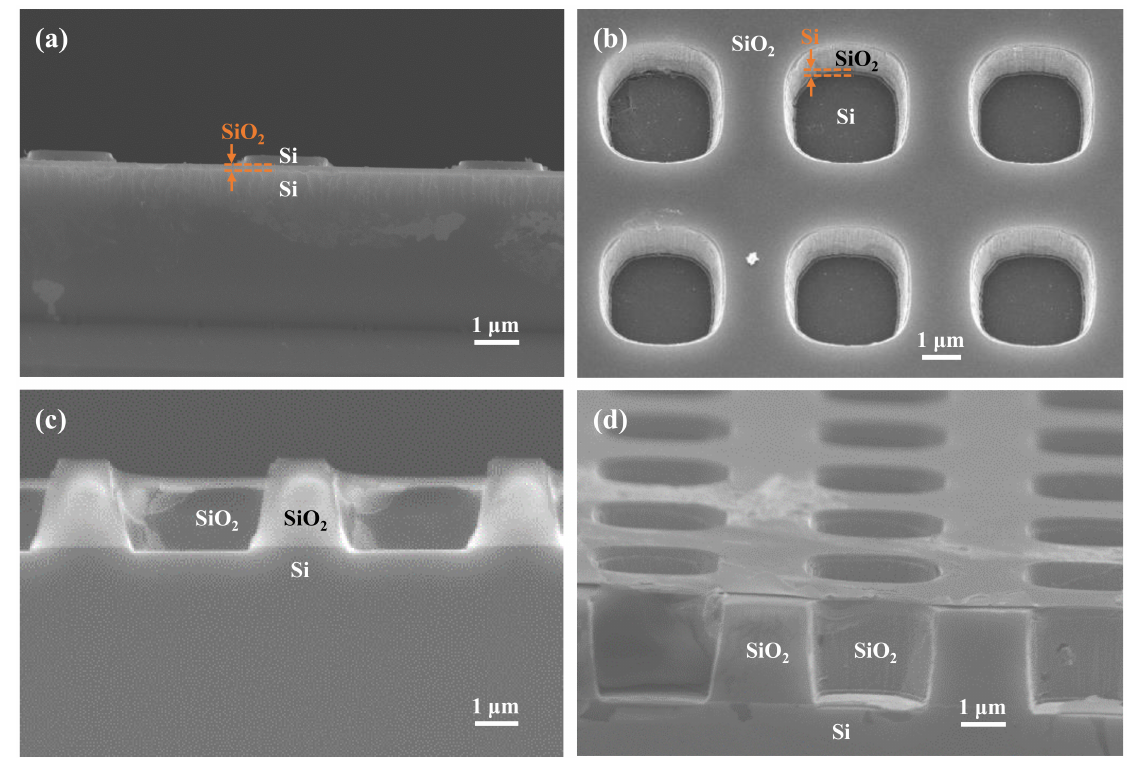
Figure 3. ( a ) Cross-sectional scanning electron microscope image of the releaser piece, ( b ) bird’s-eye-view and ( c ) cross- sectional scanning electron microscope images of the receiver piece with an SiO 2 terrace before the submergence process, and ( d ) bird’s-eye-view scanning electron microscope image of the receiver piece with an SiO 2 terrace after the submer- gence process.